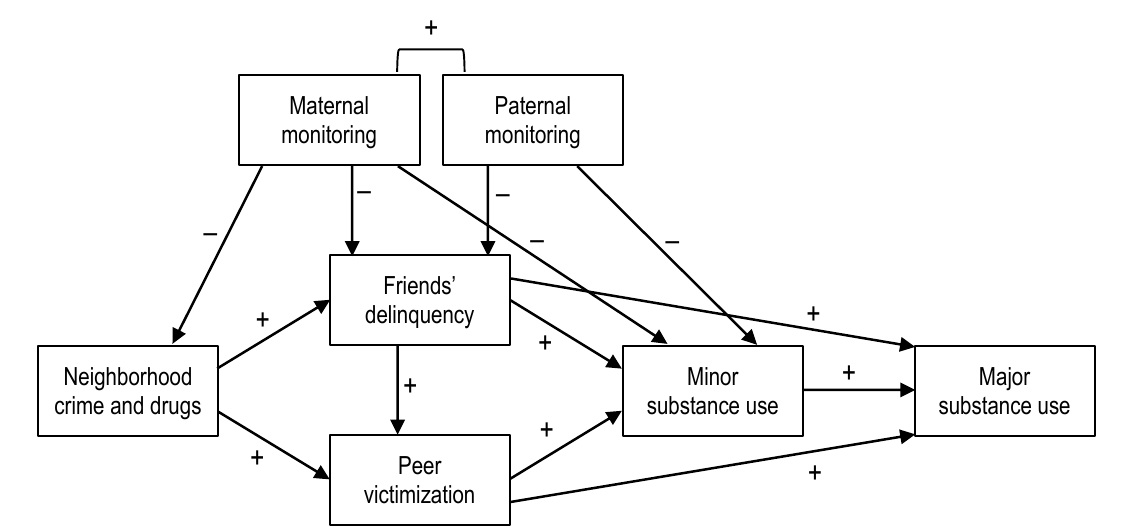
Figure 1. Theoretical model examining neighborhood, peer, and parenting antecedents of substance use in Latino and Black adolescents.